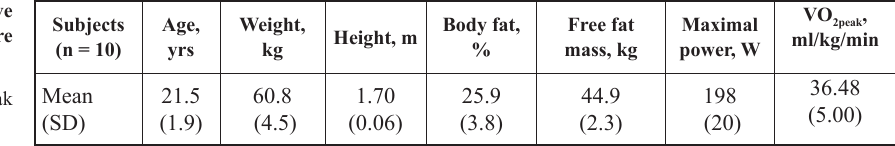
Table. Subjects’ descriptive characteristics. Values are means (SD) Note. VO – relative peak 2peak oxygen